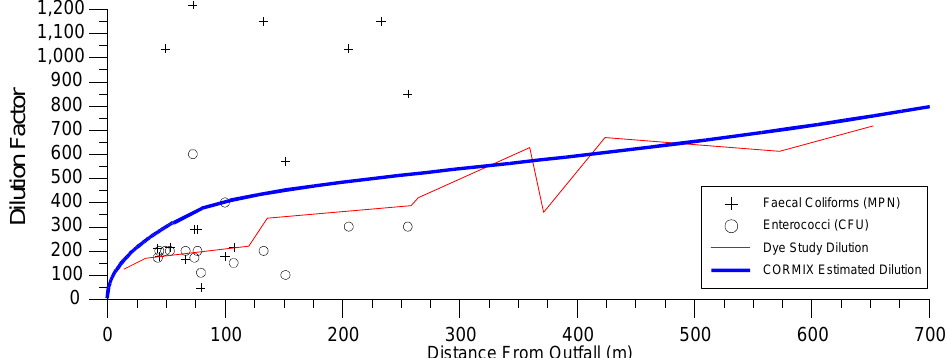
Figure 7. Summary of dye dilutions determined from the continuous releases. The recreational area surf break is represented by the black symbol ≈ 850 m NE of the outfall. Concentrations of enterococci ranged from <1 to 11 CFU/100 mL and met the recrea- tional water quality guideline (median ≤3 0 0 mL and no single sample ≥ 0 0 0 mL), including samples taken at 25 m from the outfall diffuser. Concentrations of fecal coli- forms ranged from <2 to 170 MPN/100 mL. The measured dilution levels showed that enterococcal dilutions were slightly lower than either the CORMIX estimate and the dye tracing results indicated (Figure 8). Based on these results, a DMZ was recommended ex- tending 250 m to the north and south of the diffuser, parallel to the shoreline, and 100 m shoreward and seaward.